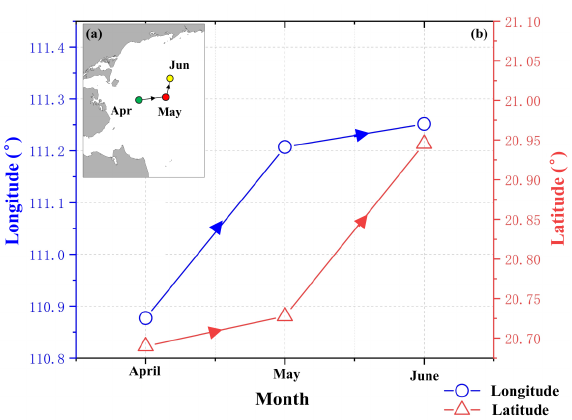
Figure 5. Changes in the central spawning-ground gravity (CoSGG) of the spawning grounds in WGWs: ( a ) moving track and ( b ) longitude and latitude of the CoSGG.